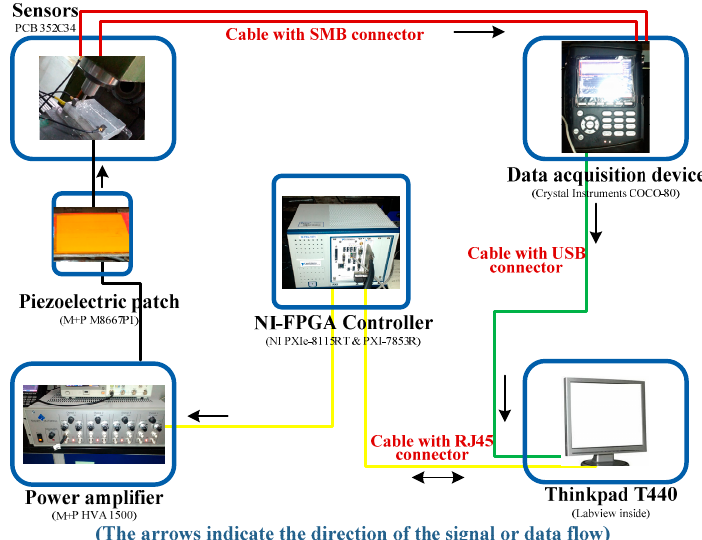
Figure 9. Data flow of the milling process experiment.